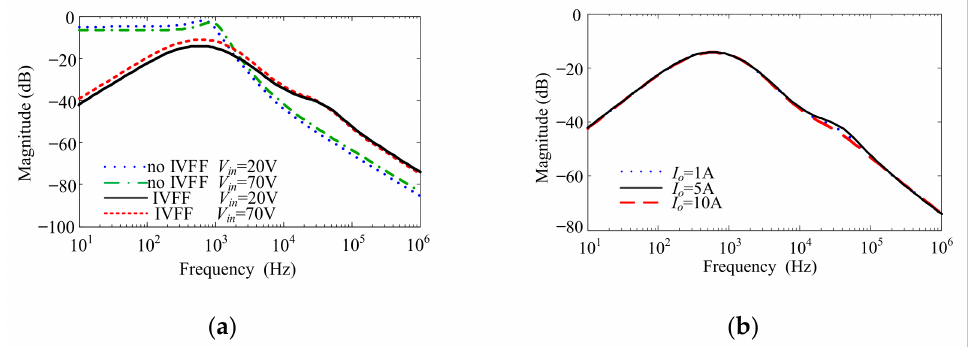
Figure 15. Bode diagrams of Φ vv . ( a ) Voltage gain. ( b ) Current